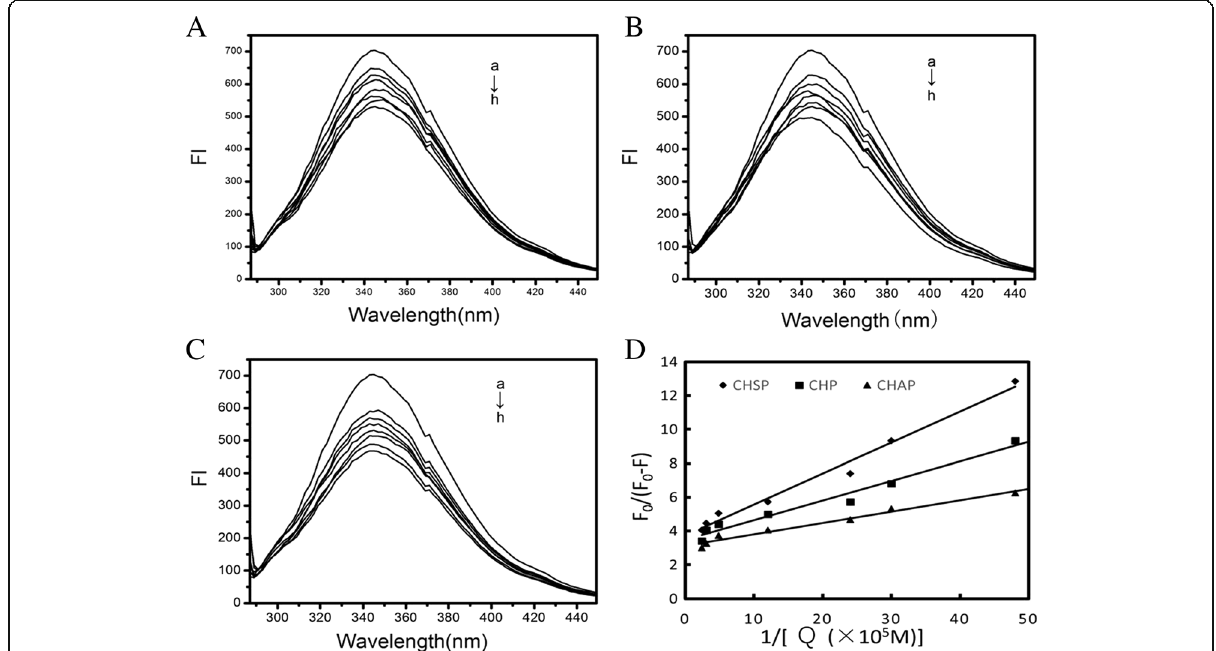
Fig. 7 Fluorescence spectra of HSA (1.5 × 10 − 5 mol/L) with CHSP ( A ), CHP ( B ), and CHAP ( C ) at different concentrations (a) 0, (b) 2.07 × 10 − 7 , (c) 3.31 × 10 − 7 , (d) 4.14 × 10 − 7 , (e) 8.28 × 10 − 7 , (f) 20.7 × 10 − 7 , (g) 33.1 × 10 − 7 , and (h) 41.4 × 10 − 7 mol/L. D Plots ( n = 7) for F 0 /( F 0 − F) vs 1/[ Q ], Q is the concentration of CHSP ( – ◆ – ), CHP ( – ■ – ) and CHAP ( – ▲ – ),